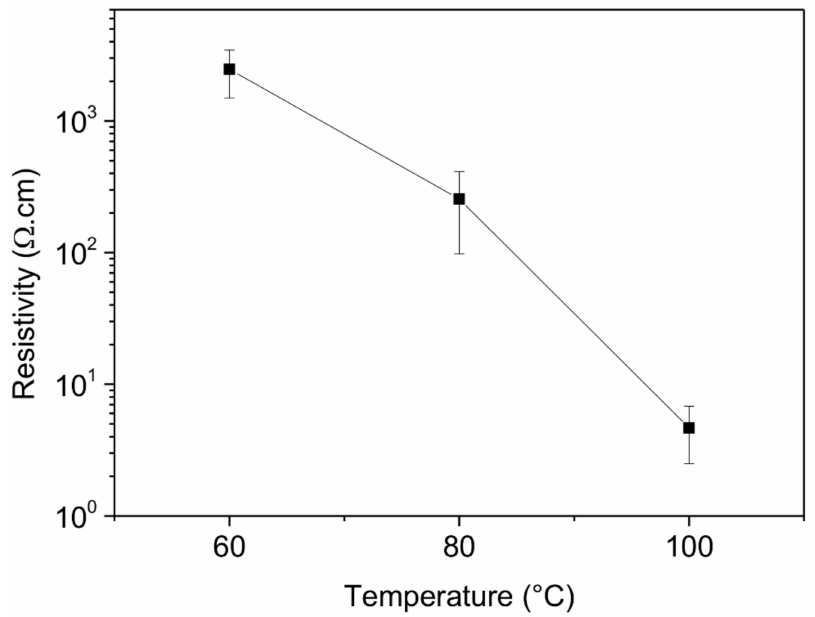
Figure 9. Evolution of the resistivity as a function of the deposition temperature for 150 nm thick ZnO thin films deposited at 60 ◦ C, 80 ◦ C and 100 ◦ C on glass substrates, measured by the four-points probe